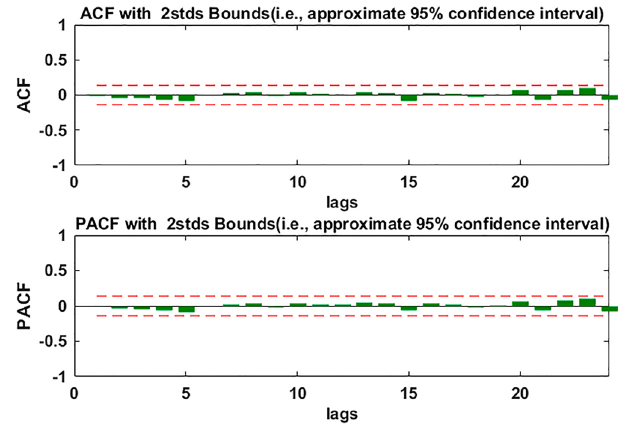
Figure 5. The ACF and PACF of SARIMA((1,2,3,4,6,7,11),2,1)(1,0,1) 12 residuals.